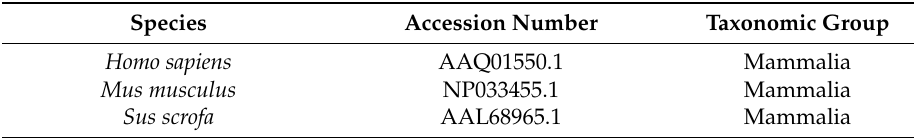
Table 2. Translationally Controlled Tumour Proteins (TCTPs) from Eumetazoans used for phylogenetic